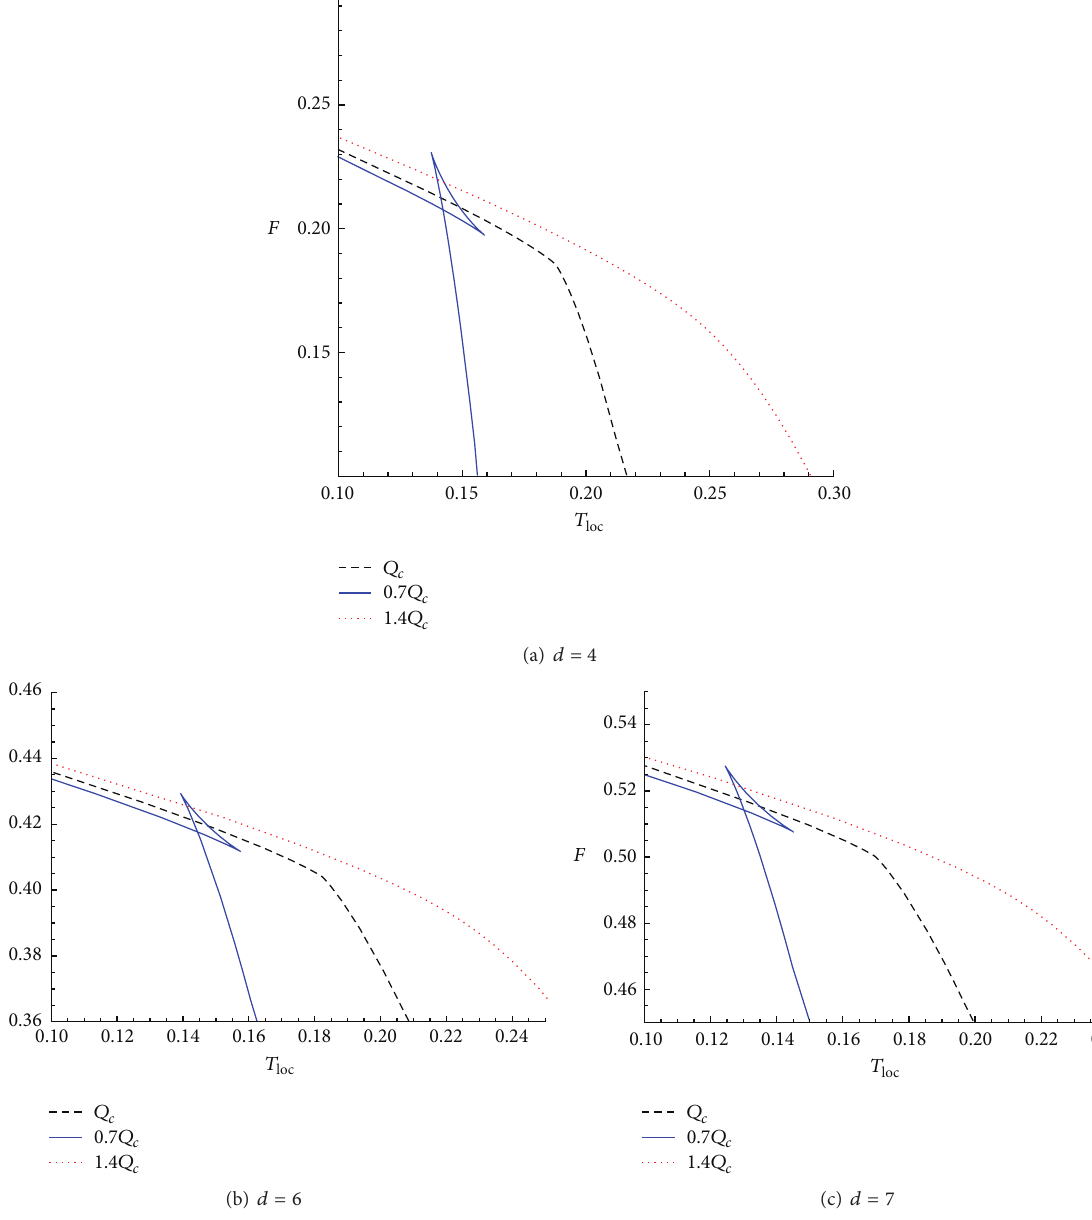
Figure 2: The 𝐹 - 𝑇 loc curves for 𝑑 = 4, 6, 7 , respectively. From top to bottom the curves correspond to the effective temperatures 0.7𝑄 𝑐 , 𝑄 𝑐 , and 1.4𝑄 𝑐